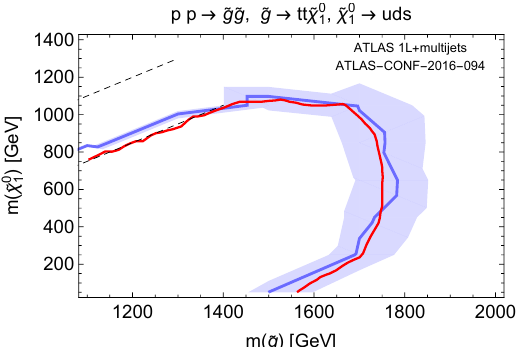
Figure 15 . Limits on supersymmetric simpli(cid:12)ed models from our recasted search of [34] (blue line) with 50% error on the number of events in the signal regions (blue shaded region), compared to the experimental results (red